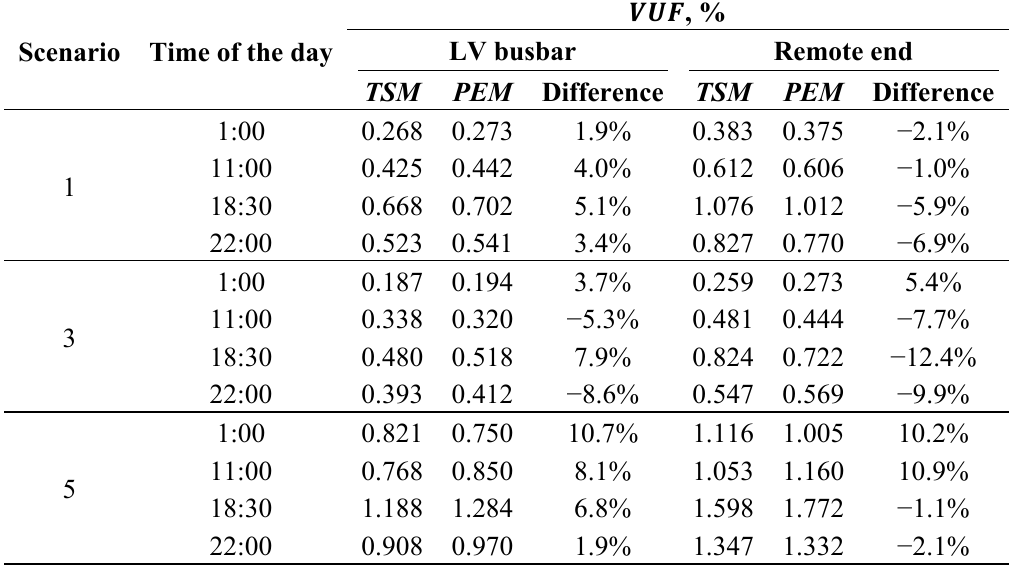
Table 4. 𝑉𝑈𝐹 s comparison by using PEM and